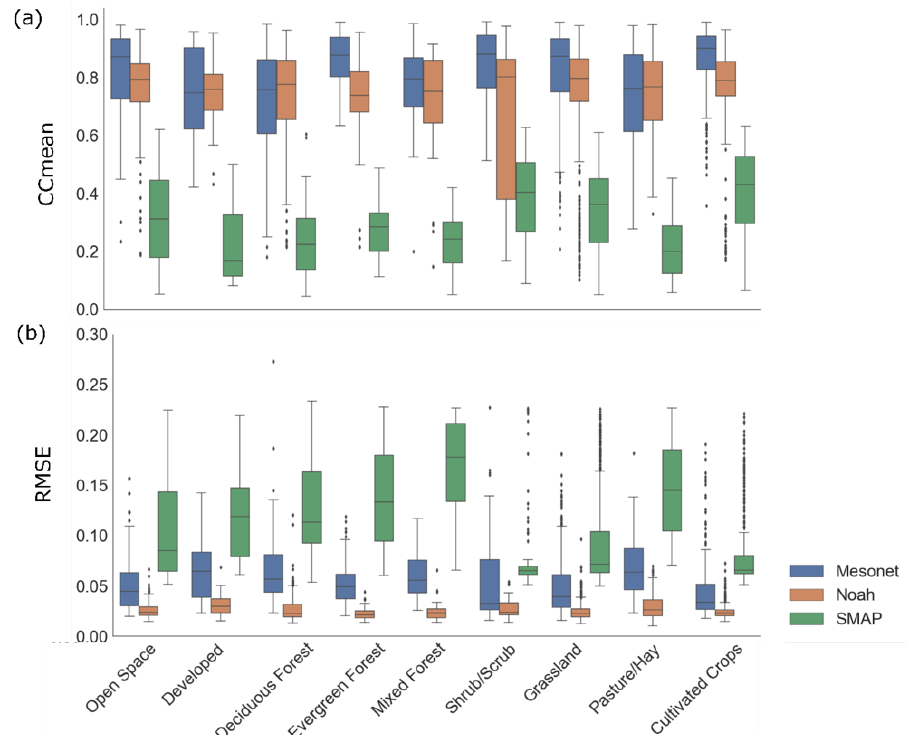
Figure 9. Soil moisture product intercomparison results using the TC method for Mesonet, Noah, and SMAP based on ( a ) CC and ( b ) RMSE for values at local 6 a.m., for nine Oklahoma state representative land cover types (see Table 3) from April 2015 through July 2019.